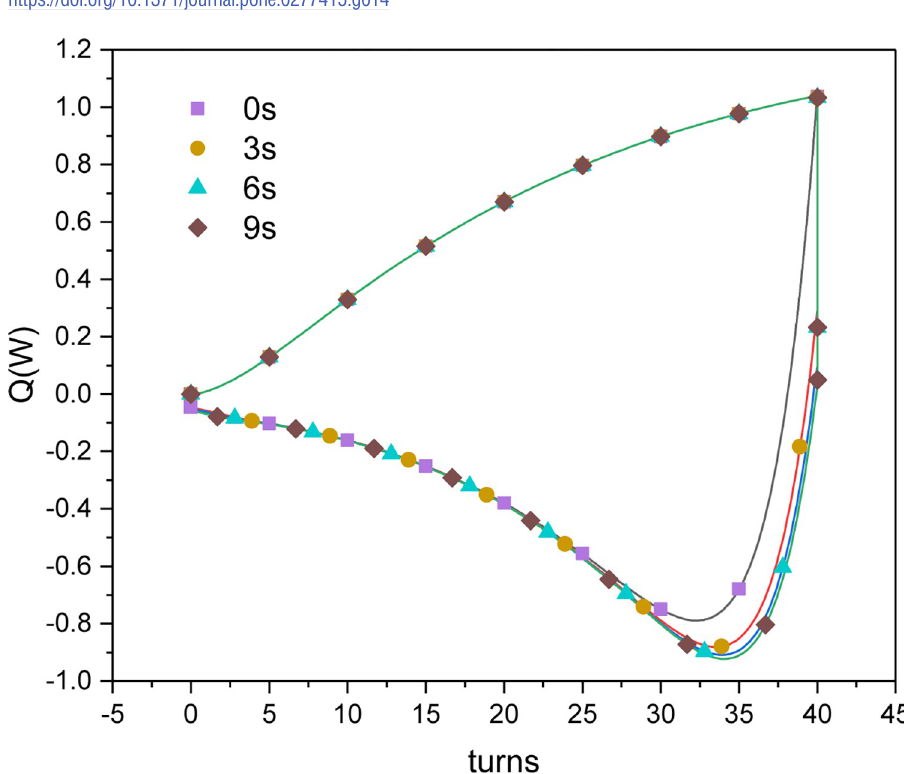
Fig 15. Simulated cooling and heating capacities of the nitinol wires in a continuous torsional refrigeration unit as functions of buffering time ( u = 0.5 m/s, n = 50rpm). 1